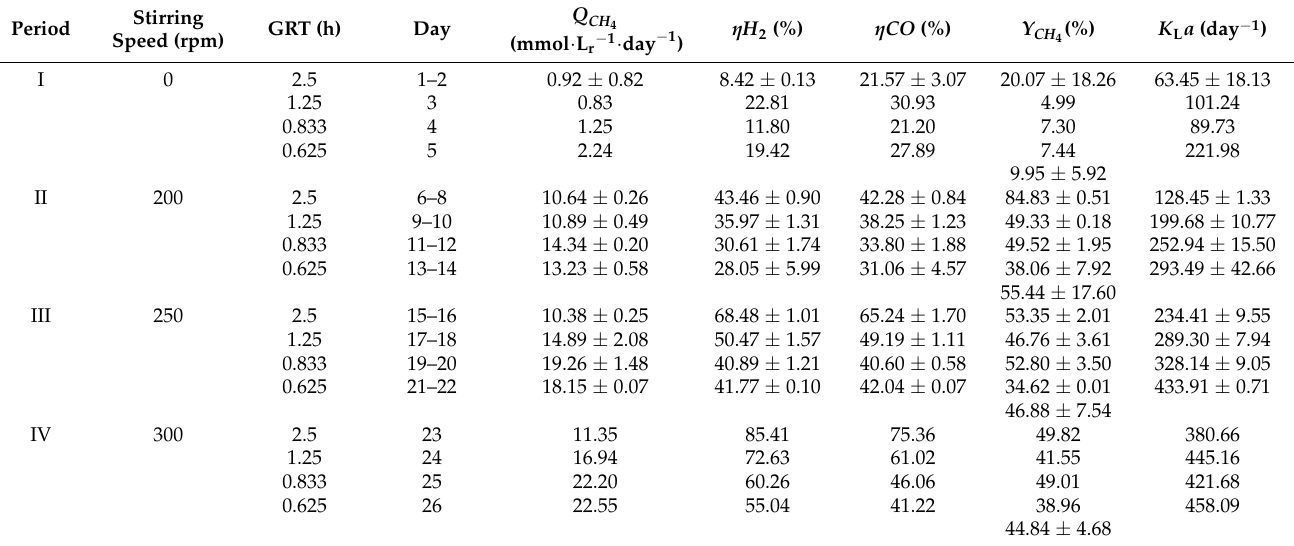
Table 2. Syngas biomethanation performances of the CSTR in 4 experimental periods with different stirring speeds and